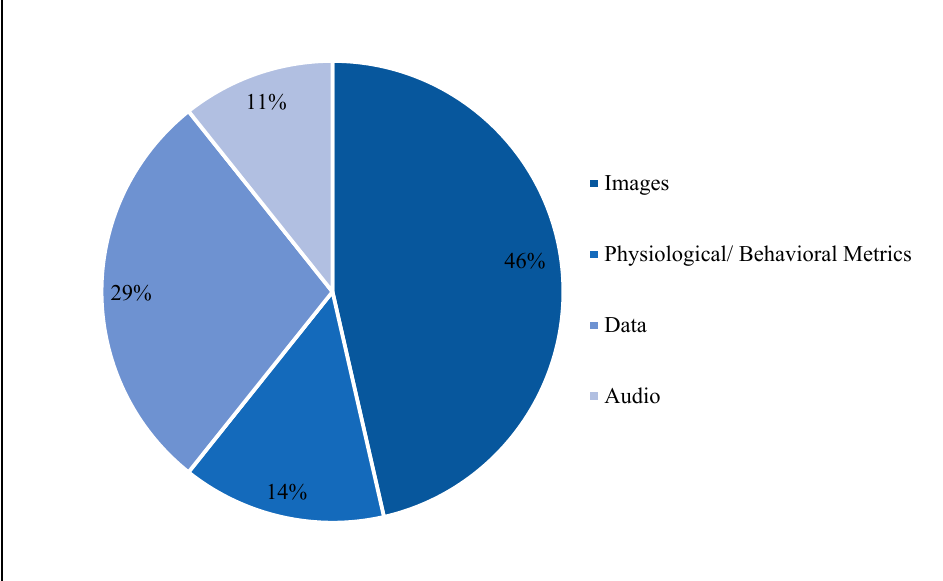
Figure 4. Dataset type distribution in previous studies.